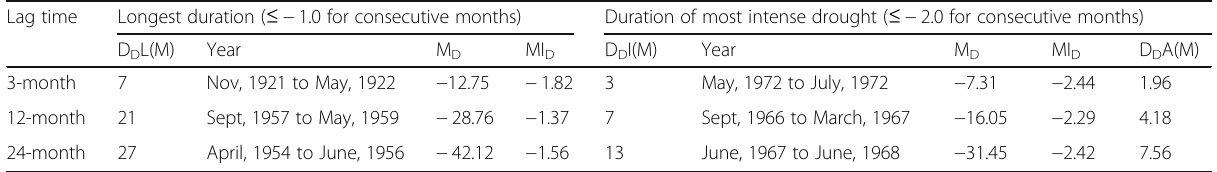
Table 4 Drought duration and magnitude distinctiveness at different time scale for the GWB during 1901 – 2002 Lag time Longest duration ( ≤ − 1.0 for consecutive months) Duration of most intense drought ( ≤ − 2.0 for consecutive